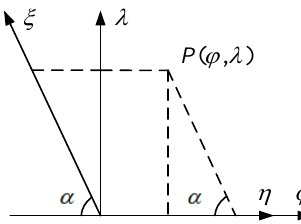
Figure 2. Schematic diagram of coordinate conversion.